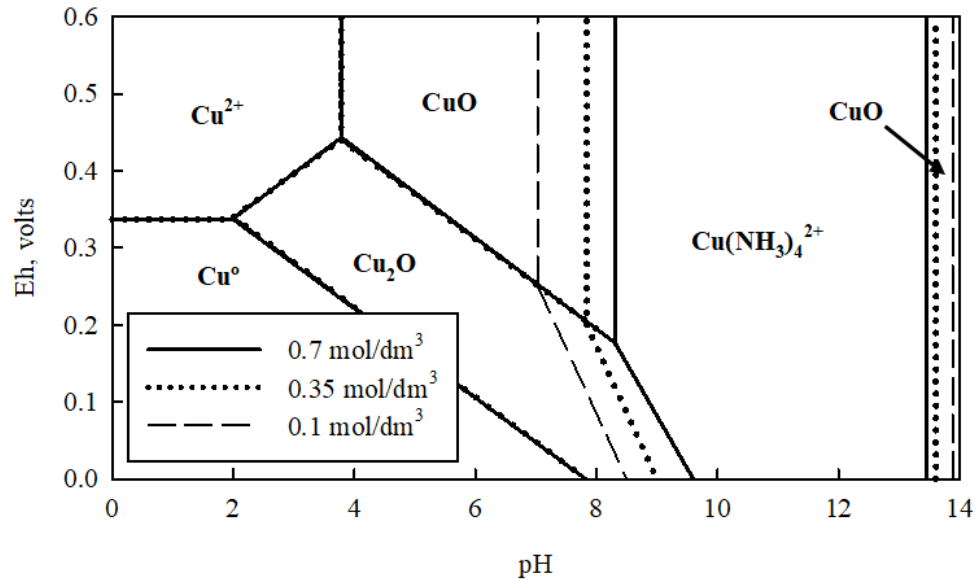
Figure 8. Stability diagram of the NH 3 -Cu-H 2 O system for a temperature of 278 K. NH 4 OH concentrations = 0.7, 0.35 and 0.1 mol/dm 3 . Copper concentration = 0.00236 mol/dm 3.